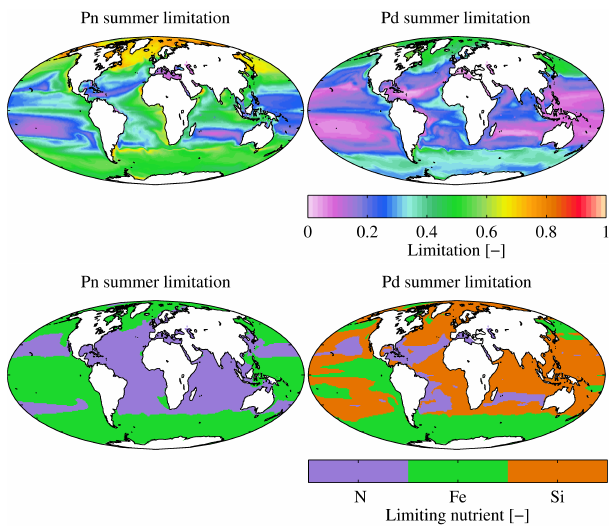
Fig. 30. Simulated summertime average non-diatom (top) and diatom (bottom) integrated nutrient limitation (left) and most-limiting nutrient (right). Limitation is weighted by biomass and integrated for the full water column. Limitation is dimensionless.